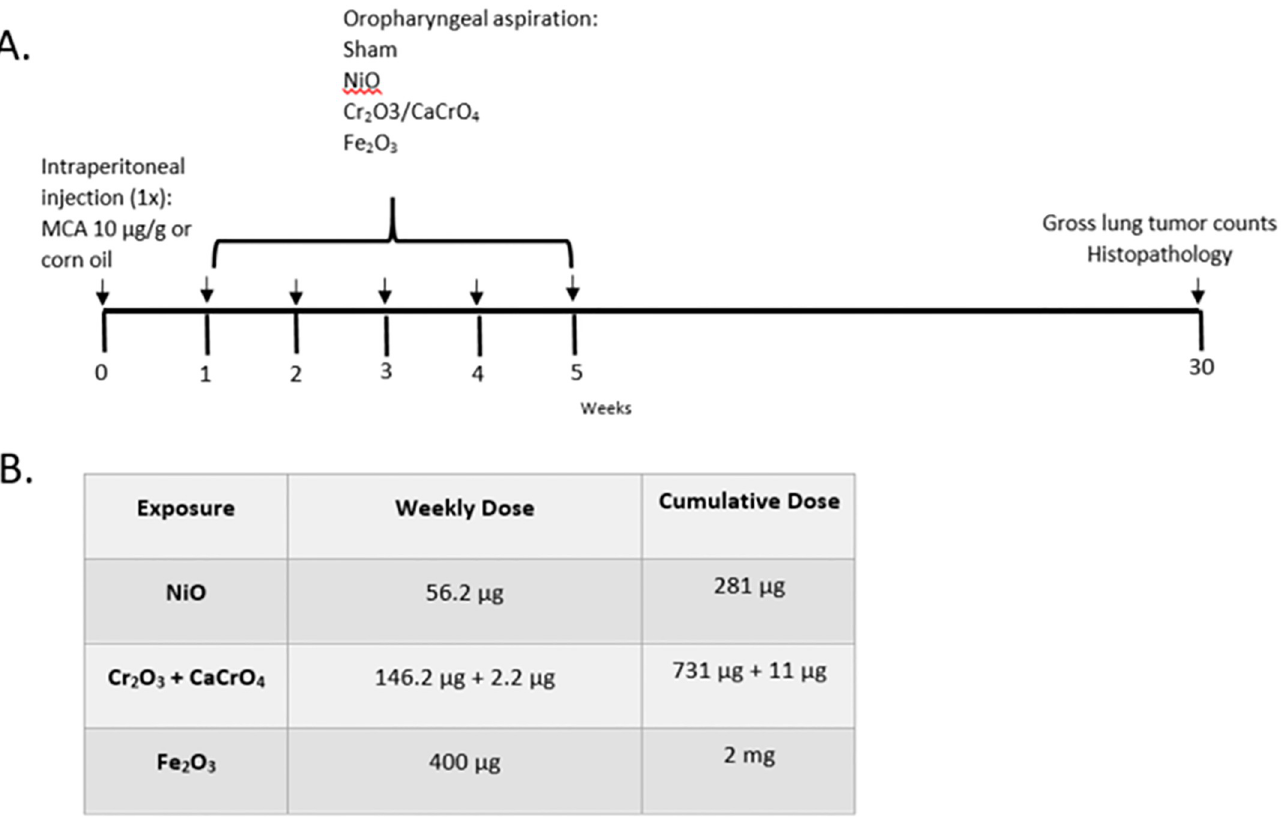
Fig 3. Experimental protocol 2: Two-stage initiation-promotion lung tumor bioassay. 200 male A/J mice were organized into 5 groups: MCA/NiO, MCA/ Cr 2 O 3 + CaCrO 4 , MCA/ Fe 2 O 3 , MCA/sham, or CO/sham. Beginning 1 week post-initiation with MCA or CO, mice were exposed to the metal oxide or sham by oropharyngeal aspiration once per week for 5 weeks (panel A). Doses of metal oxides were the cumulative high doses from experimental protocol 1 (panel